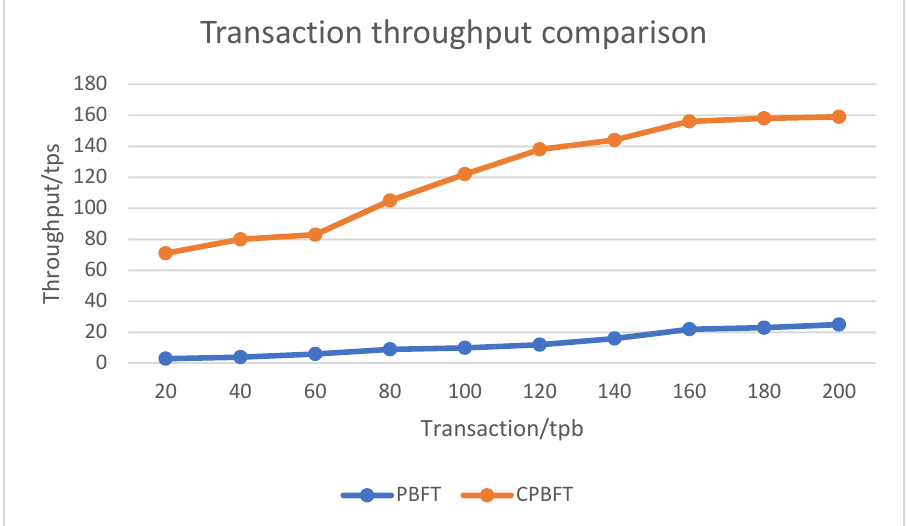
Figure 8. Comparison of CPBFT and PBFT transaction throughput.